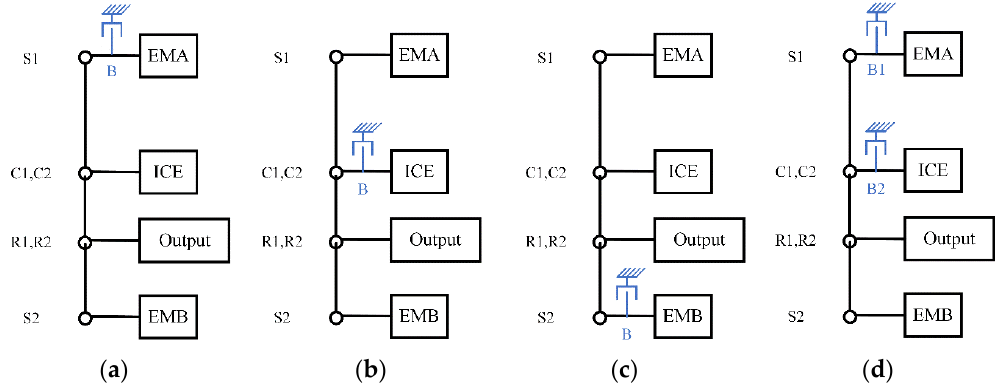
Figure 7. ( a ) Adding a brake on the node of EMA; ( b ) Adding a brake on the node of ICE; ( c ) Adding a brake on the node of EMB; ( d ) Adding two brakes on both EMA and ICE.